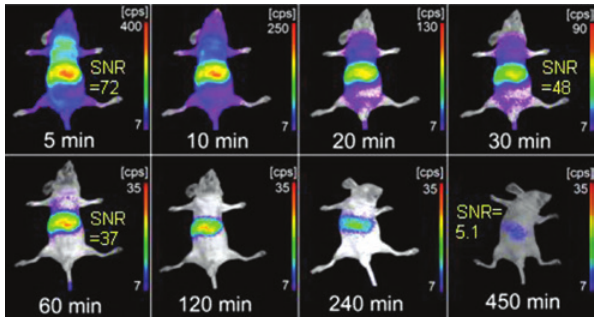
Figure 14: In vivo NIR luminescence images for increasing times of a normal mouse after intravenous injection of Zn Pr 3 + PLNPs (0.6 mg, 10 min irradiation with a 254 nm UV lamp before